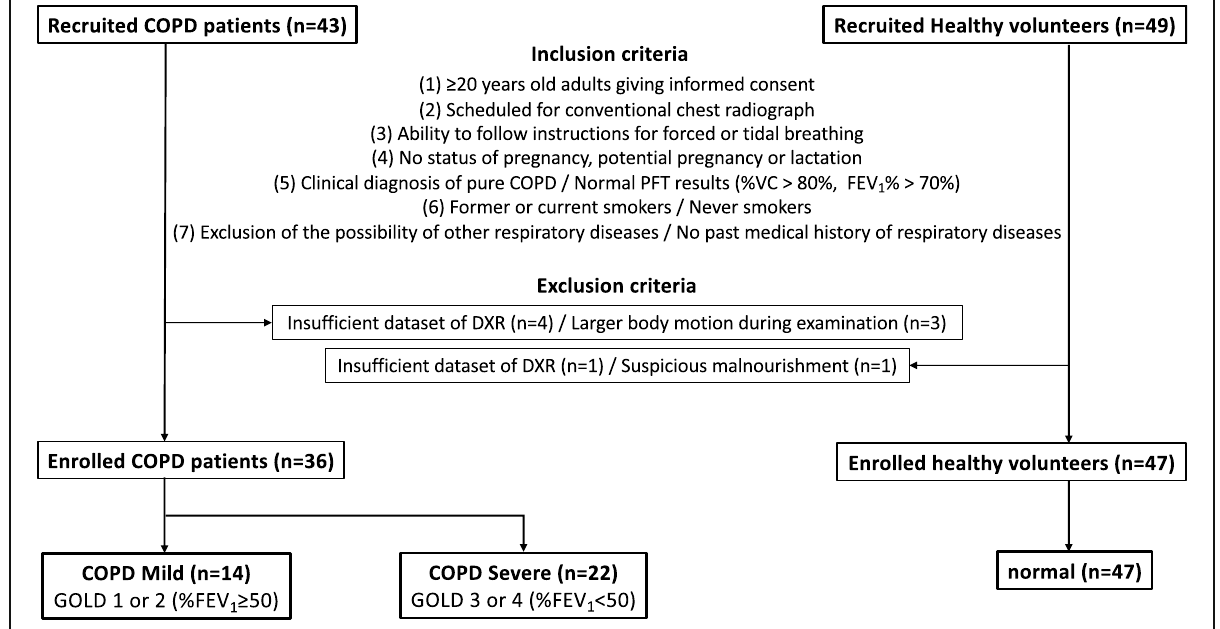
Fig. 1 Flow chart of inclusion and exclusion criteria for this study. COPD Chronic obstructive pulmonary disease, DXR Dynamic x-ray, FEV 1 % Forced expiratory volume percent in one second divided by forced vital capacity, GOLD Global initiative for chronic obstructive lung disease, PFT Pulmonary function test, %VC Percent predicted vital